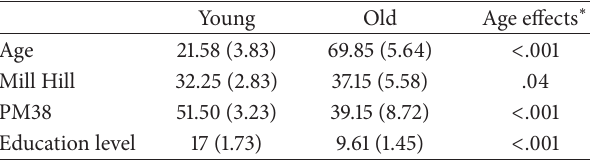
Table 1: Participants’ demographic